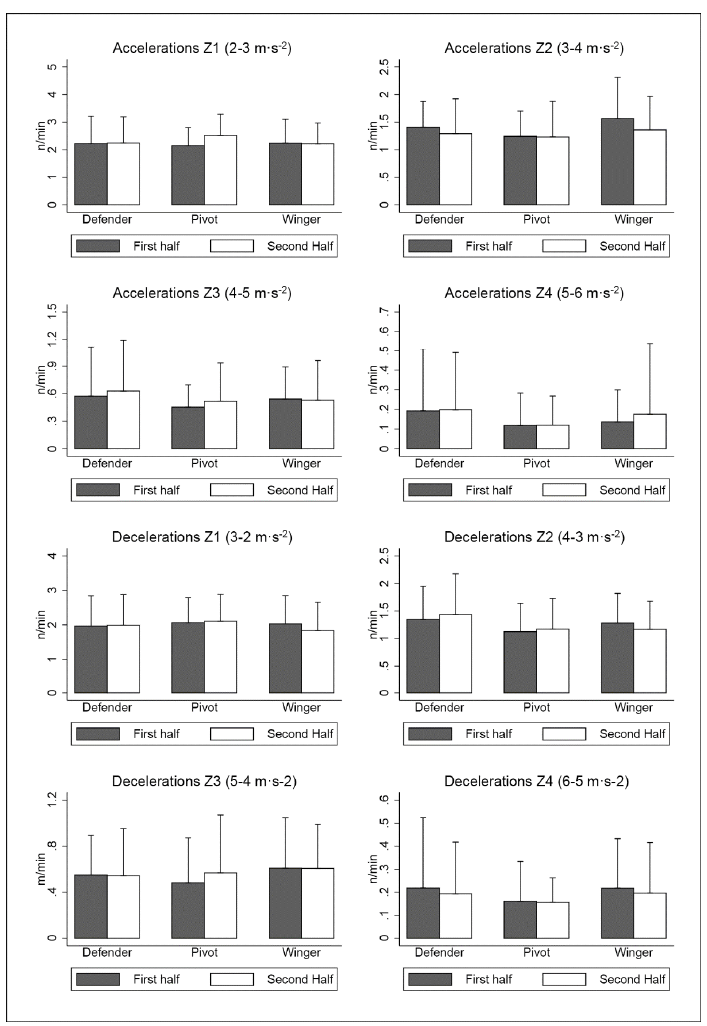
Figure 2. Relative distance covered in different speed ranges. b significant differences with respect to pivot ( p < 0.05). Abbreviations: Z1, zone 1; Z2, zone 2; Z3, zone 3; Z4, zone 4. The analysis of the accelerations and decelerations in different ranges of intensity did not show significant differences related to players’ position and the period of the match ( p > 0.05; Figure 3).